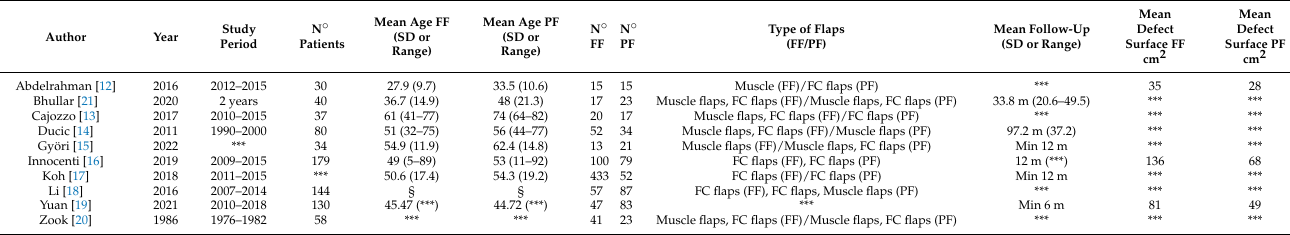
FF = free flap/PF = pedicled flap/FC = fascio-cutaneous; § Median age of the whole population provided 37.9 (3–74); *** Data not reported in the